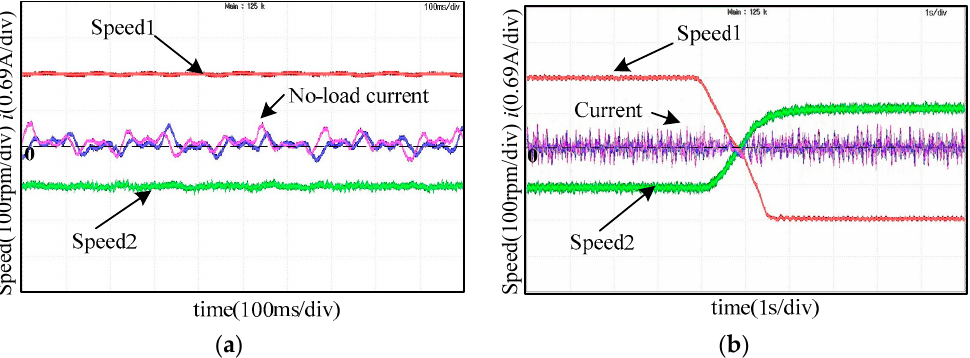
Figure 19. The current and speed waveform of speed close − loop control with current compensation under no load: ( a ) close − loop steady state; ( b ) close − loop speed adjustment.